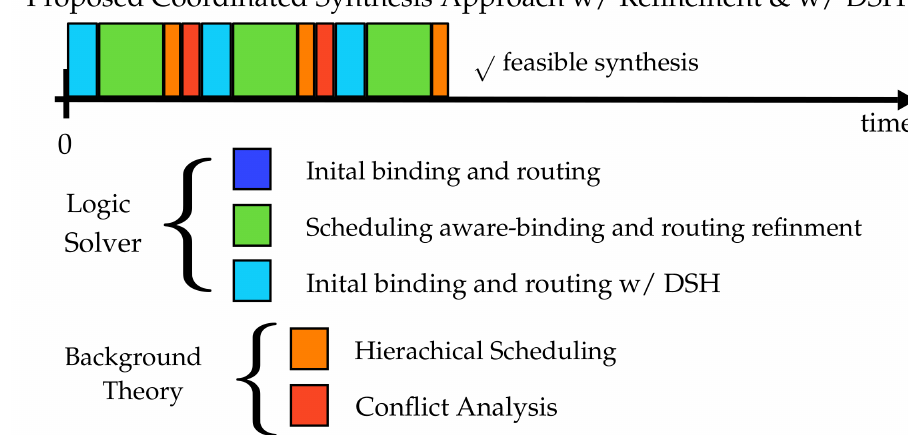
Figure 3. Illustration of the disadvantages of the classical synthesis approach along wit the advantages of the coordinated and coordinated + DSH approach. The classical approach spends a considerable amount of time within the background theory until reaching a timeout. The coordinated synthesis approach significantly increases the applicability of symbolic system synthesis by introducing an additional scheduling-aware binding and rounting refinement. The coordinated + DSH approach, which includes domain-specific heuristics (DSH) in the logic solver, furthermore increases the scalability of the coordinated approach and reduces the average synthesis time,